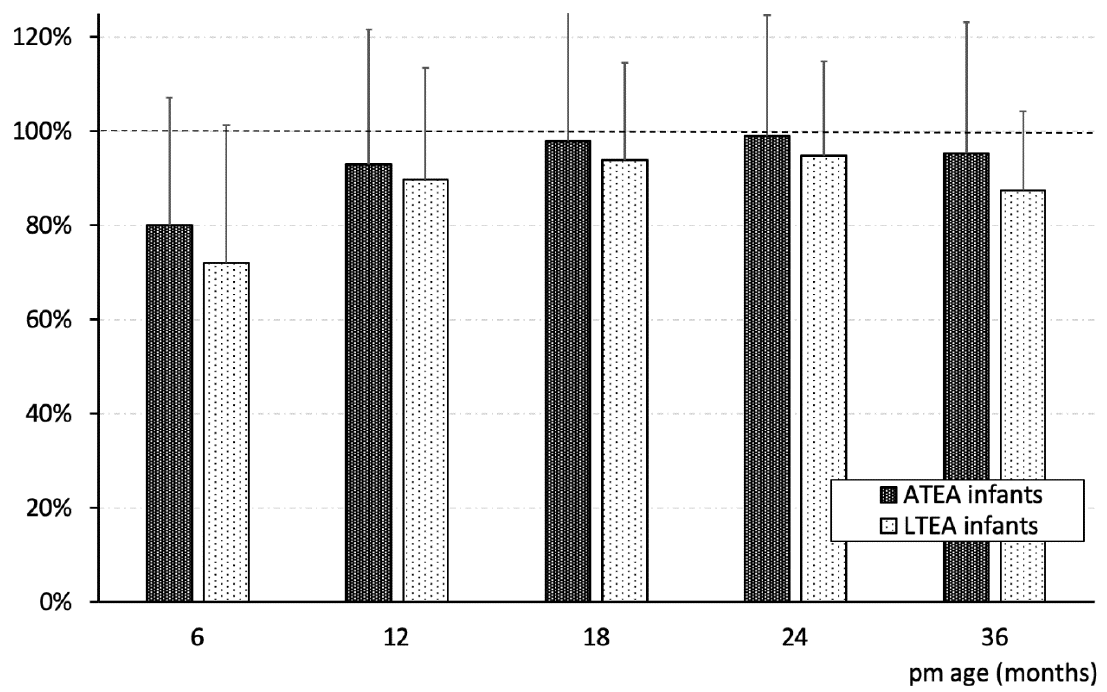
Figure 2. Time course of bone mineral content/length 2 (g/mm 2 ) in light and appropriate for term equivalent age (LTEA and ATEA) preterm infants as percentage of term infants. Data are given as mean ±